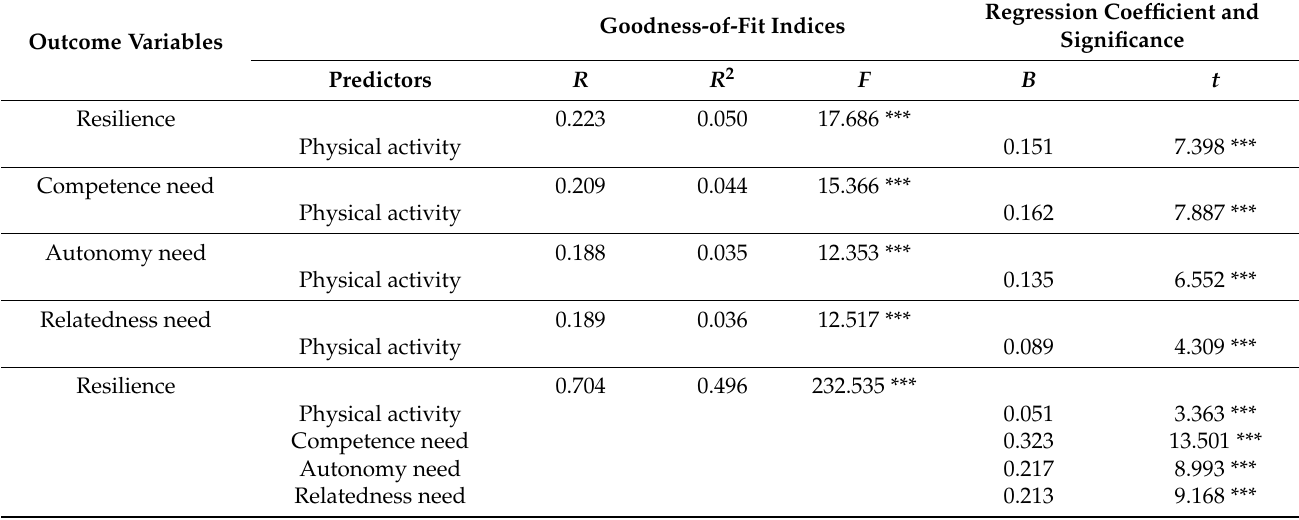
Table 2. Regression coefficients of the mediating of basic psychological needs satisfaction between physical activity and resilience.